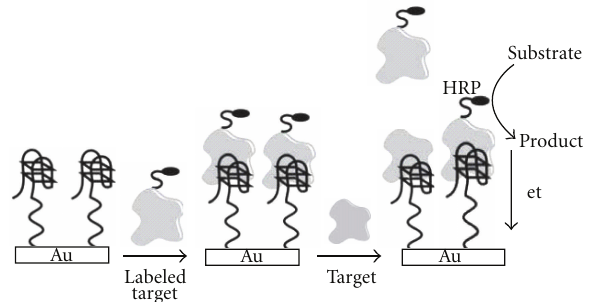
Figure 2: Competition (or displacement) assays: target molecules in a sample displace labeled-target molecules previously bound to the sensor